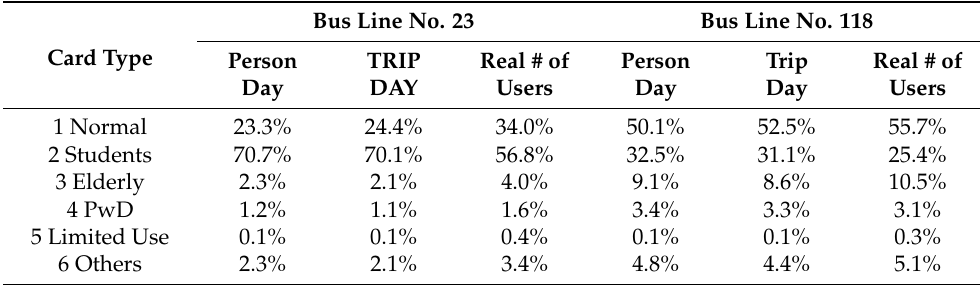
Table 5. Distribution of users and boarding frequency considering card types: daily vs. real (in a